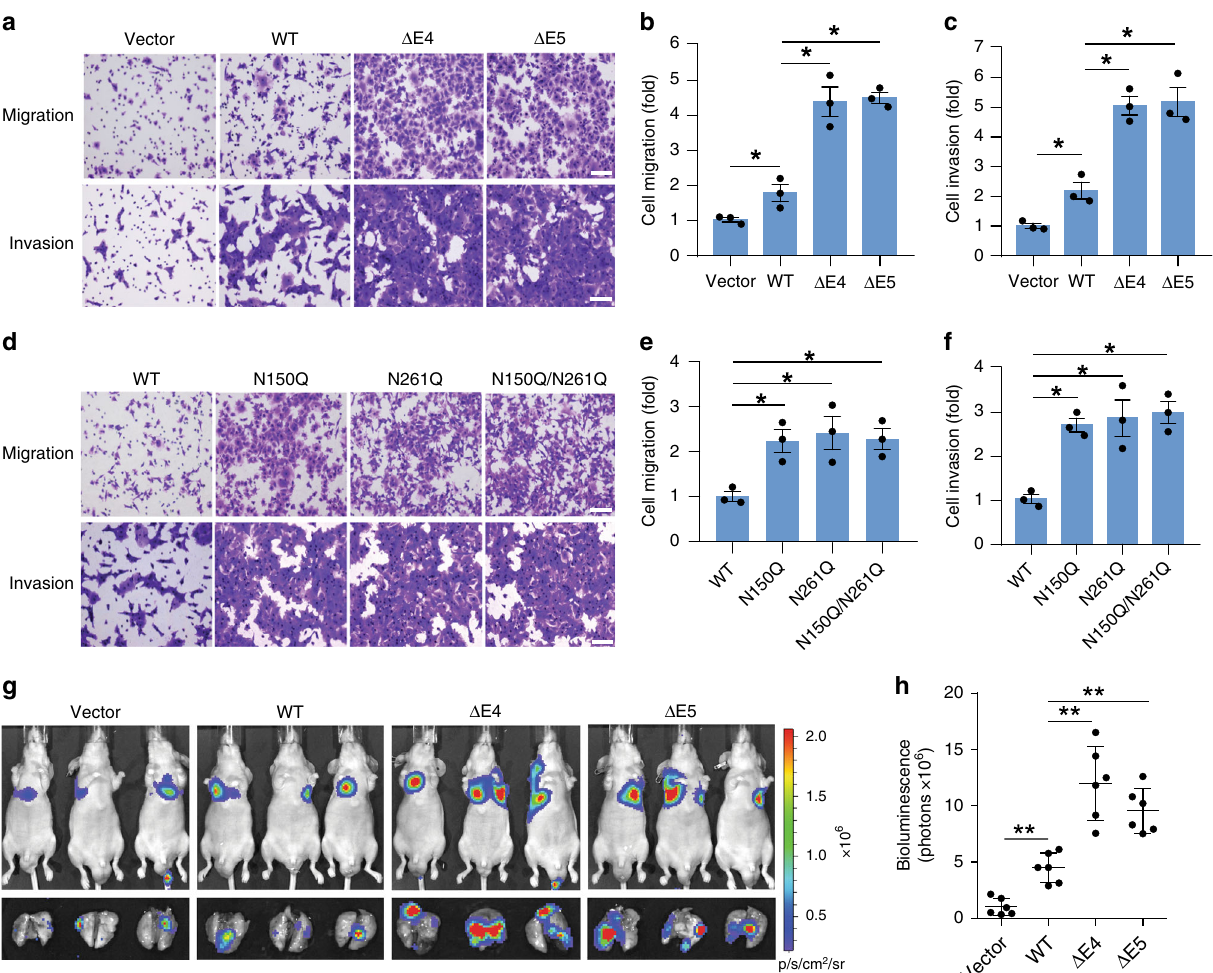
Fig. 5 N-glycosylation-defective NRP1 splice variants increases metastatic capacity. a – c Transwell migration and invasion analyses of HCT116 cells with stable expression of NRP1-WT, NRP1- Δ E4, NRP1- Δ E5 or vector control over 6 h and 30 h of incubation, respectively. Scale bars, 100 µ m. The number of migrated and invaded cells per fi eld ( n = 5) were counted. The results were expressed as a fold increase over the migrated b or invaded c cell number found in vector control cells. d – f Transwell migration and invasion analyses of HCT116 cells with stable expression of NRP1-WT or mutants over 6 h and 30 h of incubation, respectively. Scale bars, 100 µ m. The number of migrated cells per fi eld ( n = 5) were counted. The results are expressed as